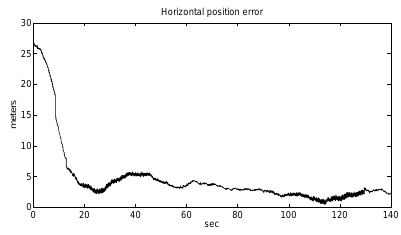
Figure 6: Convergence of the position estimate.